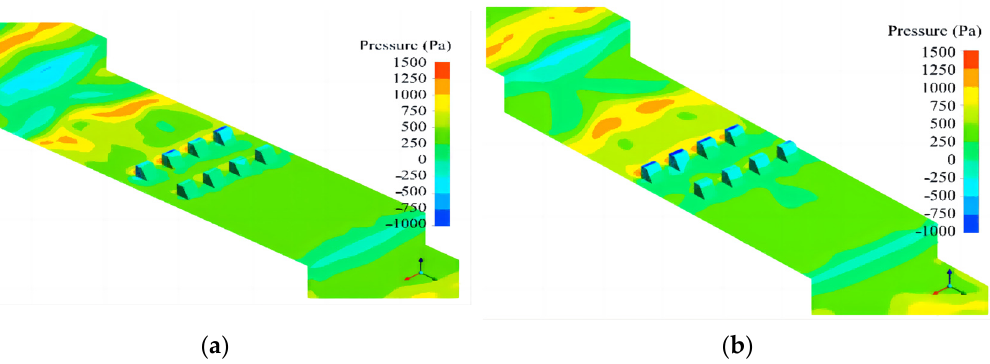
Figure 12. Segmented pier-type step dissipation pressure distribution at Q = 30 m 3 /h. ( a ) Double-row arrangement and ( b ) staggered arrangement.